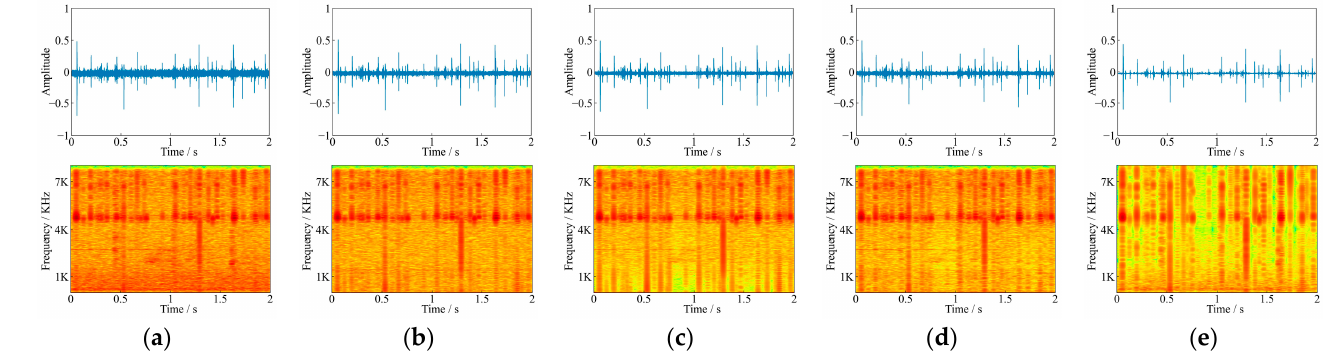
Figure 10. Comparison of waveforms and spectrograms before and after denoising for the noisy feeding sound at 6 dB ( a ) the noisy feeding sound at 6 dB; ( b ) corresponding pure feeding sound; ( c ) the denoising result of TDD-Net-DC; ( d ) the denoising result of FDD-Net-BL; and ( e ) the denoising result of wavelet denoising.